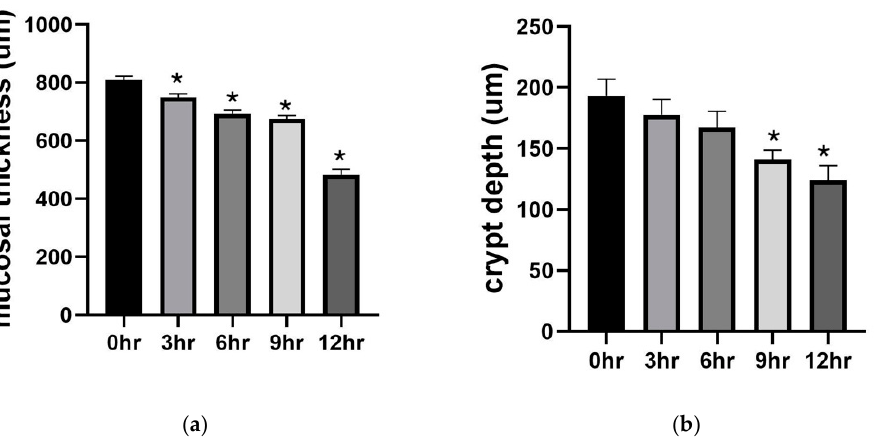
Figure 1. Morphometric analysis of the mucosa. Panel ( a ) shows changes in mucosal thickness. Panel ( b ) shows changes in crypt depth. Data are mean ± SEM, n = 6. * p < 0.05 versus the 0 h group (operated